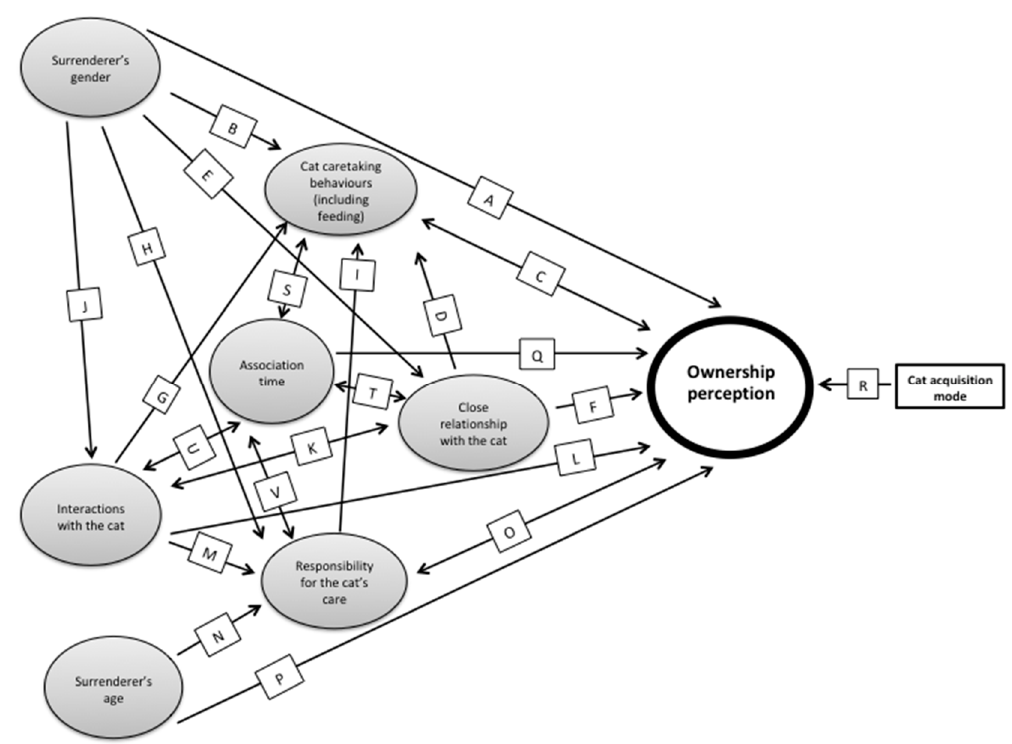
Figure 1. Proposed model of causes of surrenderer’s perceived ownership of passively acquired cats at the time the cat was surrendered; cat acquisition method is included to indicate the strong association between this variable and ownership perception (relationship R).